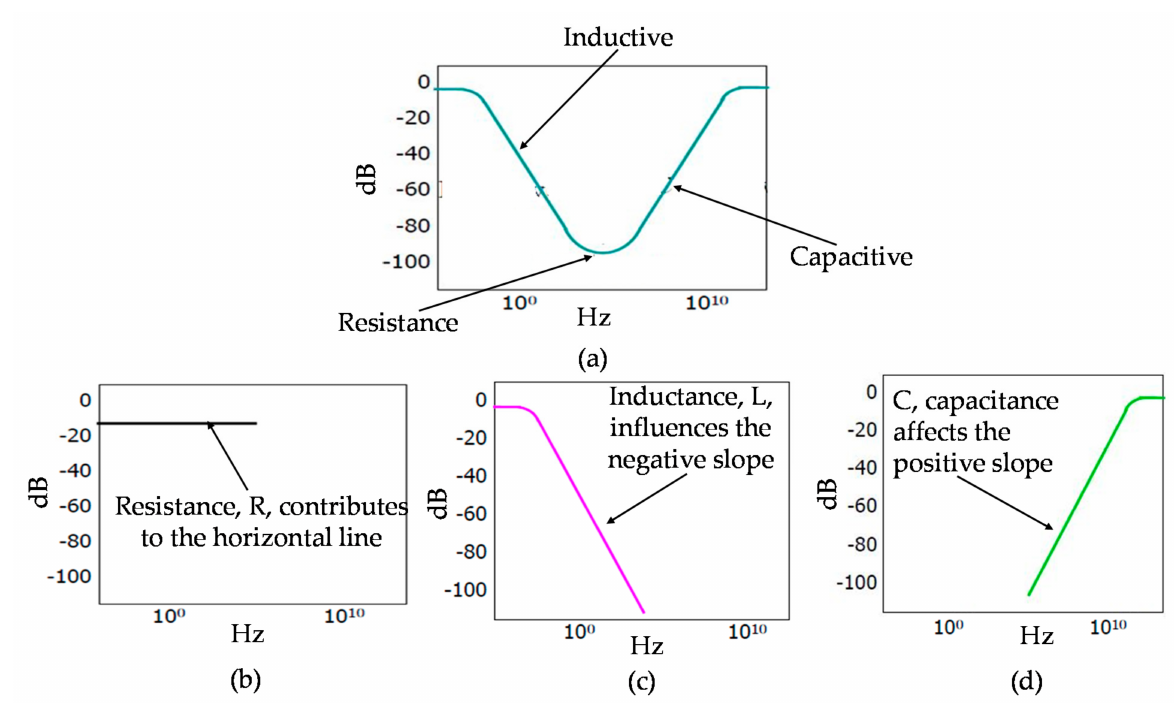
Figure 6. ( a ) Resistance, inductance, and capacitance (RLC) circuit simulated response, ( b ) effect of resistance, ( c ) effect of inductance, and ( d ) effect of